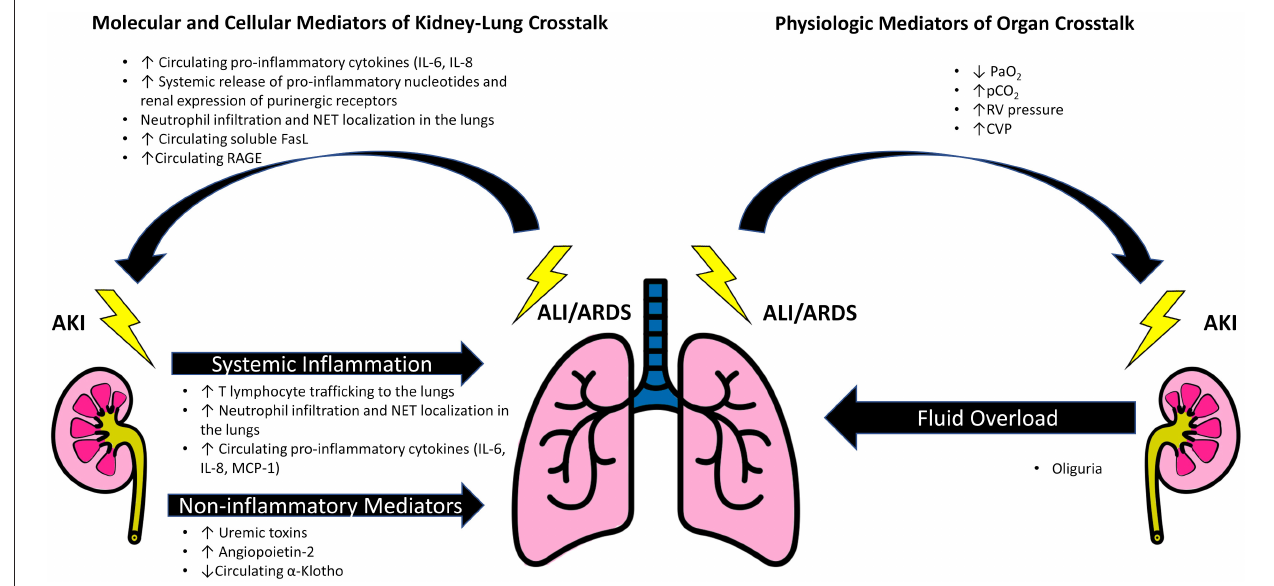
FIGURE 1 | Schematic of mediators of kidney-lung crosstalk in AKI and ARDS. Acute kidney injury propagates acute lung injury and contributes to the development of acute respiratory distress syndrome (ARDS) by generation of inflammatory cytokines, such as IL-6, increased trafficking of T lymphocytes and neutrophils to the lungs. Additionally, AKI can contribute to the development of pulmonary edema and ARDS due to the combination of fluid overload, changes in expression of pulmonary epithelial Na channels and aquaporin-5 mediated by uremic toxins, and angiopoietin-2 induced vascular leak. A reduction in circulating α -Klotho after AKI increases the lungs’ susceptibility to oxidative damage. Factors that promote renal injury after ALI/ARDS include a systemic inflammatory response associated with mechanical ventilation. Key lung mediated factors include IL-6, nucleotides, and soluble receptor for advanced glycation end products (RAGE). Increased circulating FasL induces renal tubular epithelial cell apoptosis. Additionally, the ALI/ARDS may reduce renal blood flow through the effects of hypoxia and hypercapnia on intrarenal vasculature, as well by the direct action of elevated right ventricular and central venous pressures in opposition to renal